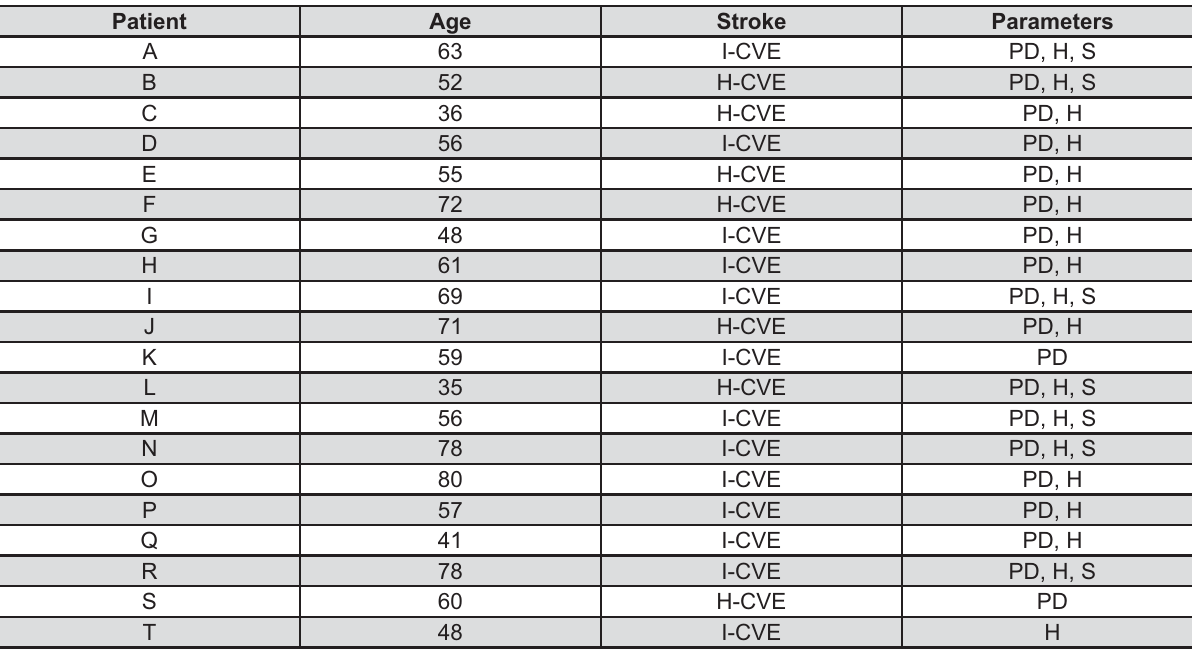
I-CVE - ischemic cardiovascular episode; H-CVE - hemorrhagic cardiovascular episode; PD – periodontal disease; H – hypertension; S – smoker Figure 4- Health questionnaire results Table 2- Periodontal status and levels of P. gingivalis detected by real-time PCR in ischemic (I-CVE) and hemorrhagic (H-CVE) cardiovascular episode